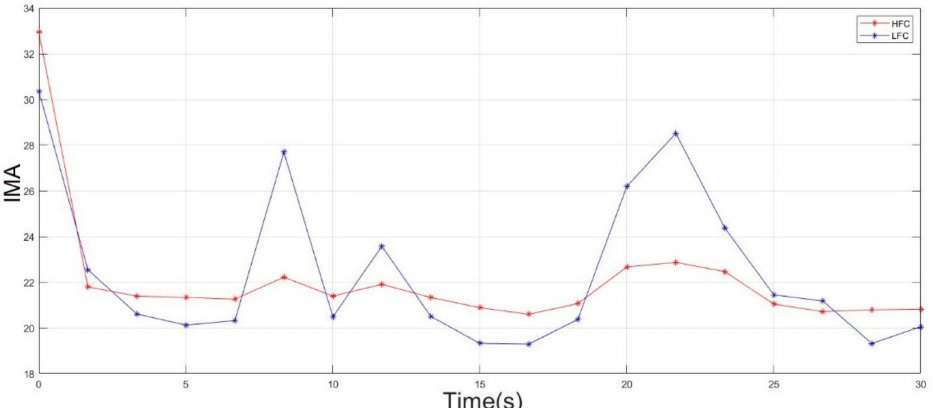
Figure 10. Behavior of IMA of the HFSS (red line) and LFSS (blue line) of the biceps at relaxed